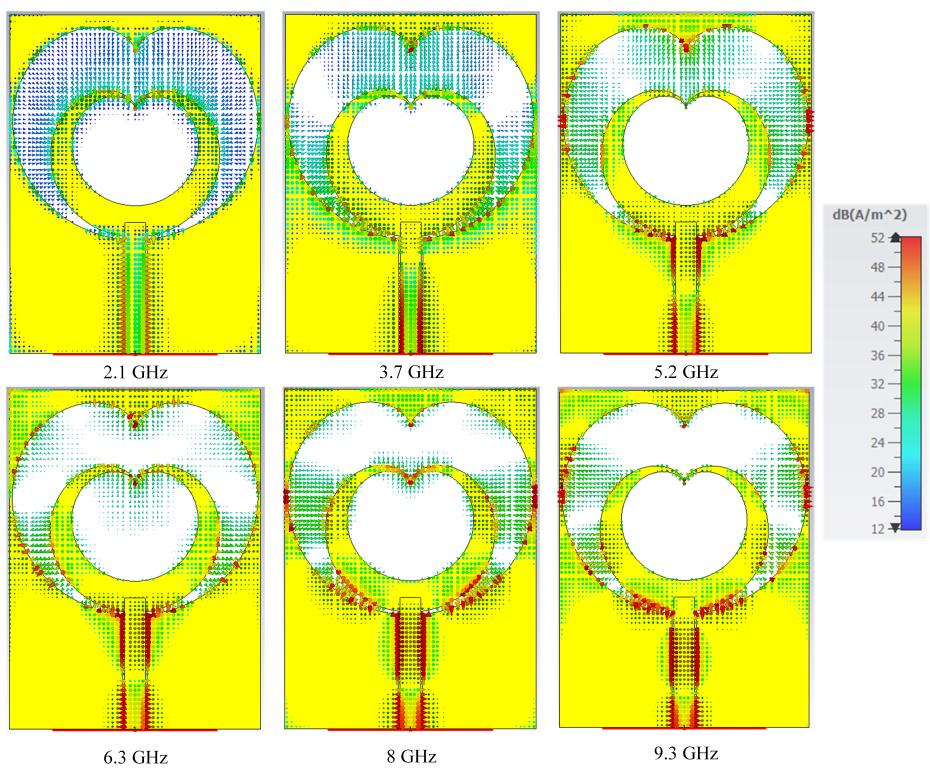
Figure 7. Current density distribution over the antenna surface at a few resonant frequencies. Simulated radiation patterns of the proposed antenna in the E-planes and H-planes are provided in the following frequencies: 1.8 GHz, 2.2 GHz, 2.4 GHz, 3.4 GHz, 5.8 GHz, 10 GHz, 13 GHz, 17 GHz, 19 GHz, 24 GHz, 28 GHz and 30 GHz. They are shown in Figure